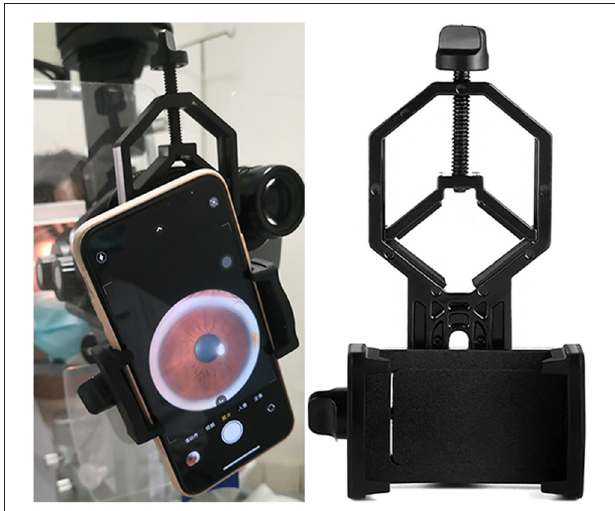
FIGURE 1 | Smartphone mounted on slit lamp in use. Anterior segment photographs were captured on study eyes using a smartphone (iPhone Xs, Apple Inc, CA, USA) attached to a slit lamp. The smartphone was fixed on the eyepiece with an adapter (Celestron 81035, Celestron Acquisition LLC, CA, USA), making the camara lens in line with the eyepiece. We used the default mode of iPhone camara with a minimal magnification (1 X) to take photographs. A Bluetooth trigger for a one-tap image capture was fixed on the joystick making the procedure of taking photographs quickly and stably. Diffuse illumination of slit-lamp was used at 45-degree angle, with magnification set at